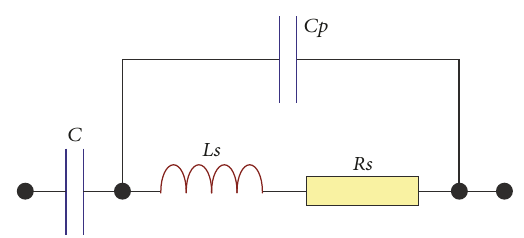
Figure 9: The equivalent circuit model for SMD capacitors.